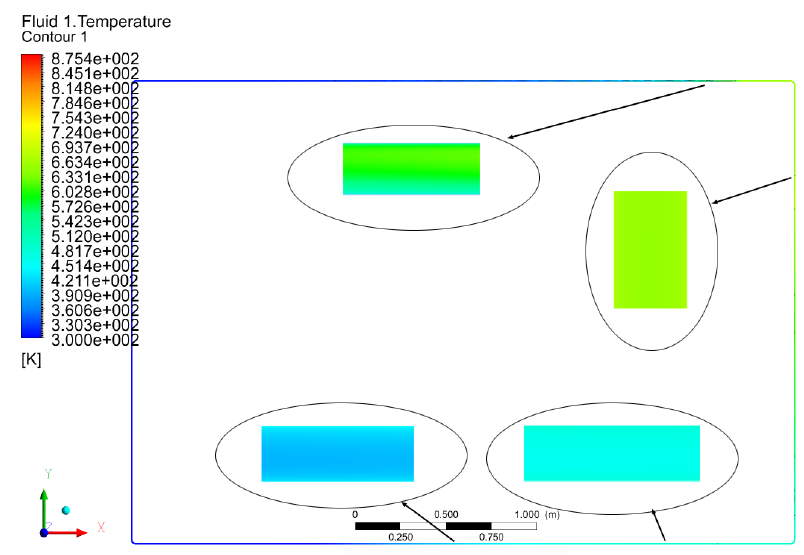
Figure 5. Temperature distribution of supercritical water natural circulation loop.